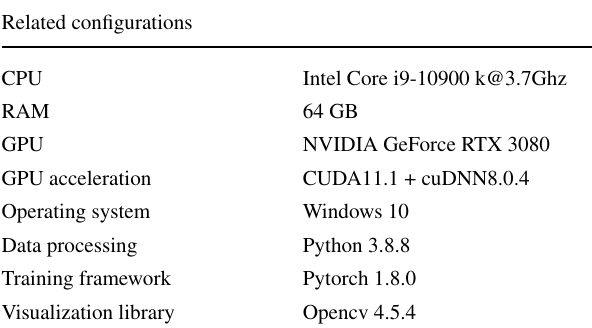
Table 1 Experimental